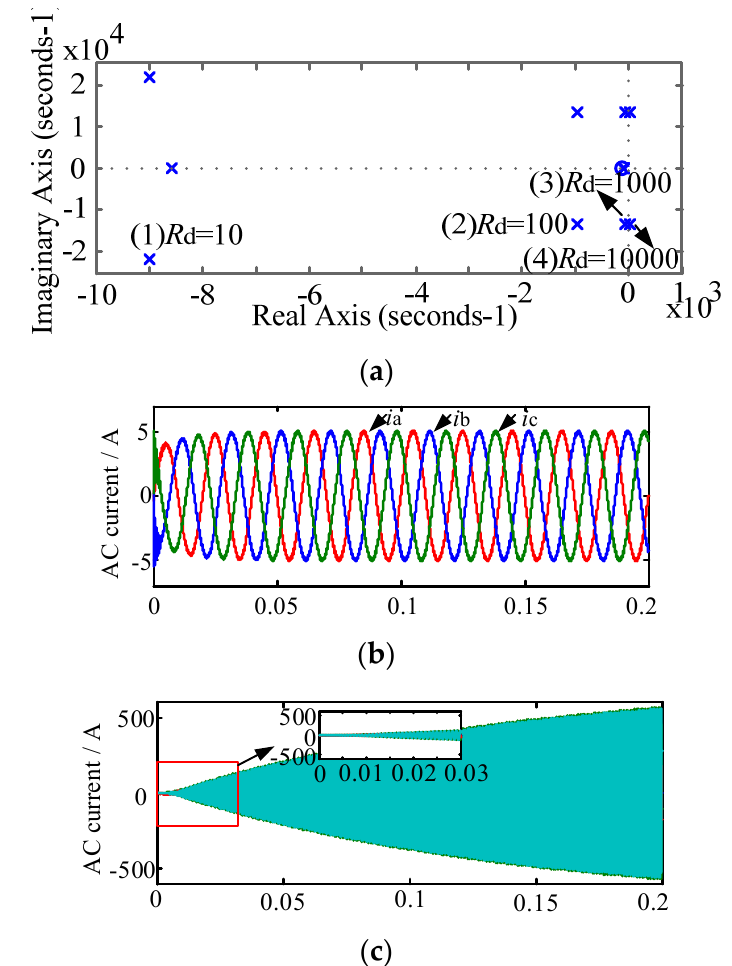
Figure 8. System stability analysis of split-inductive damping solution 1. ( a ) AC current with damping resistance of 100; ( b ) AC current with damping resistance of 100; ( c ) AC current with damping resistance of 10,000.